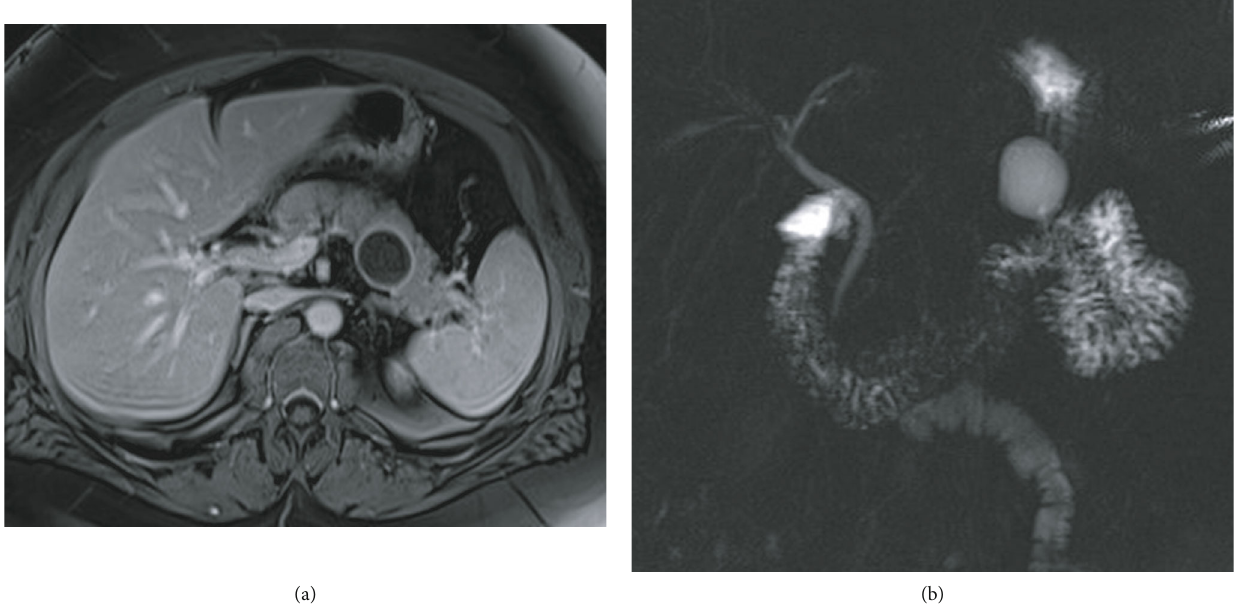
Figure 1: (a) Axial post contrast MRI demonstrates a 3.3cm pancreatic body/tail cystic lesion without enhancing nodules. (b) MRCP demonstrates a pancreatic body cystic lesion with no discrete connection with the pancreatic duct and a normal pancreatic duct